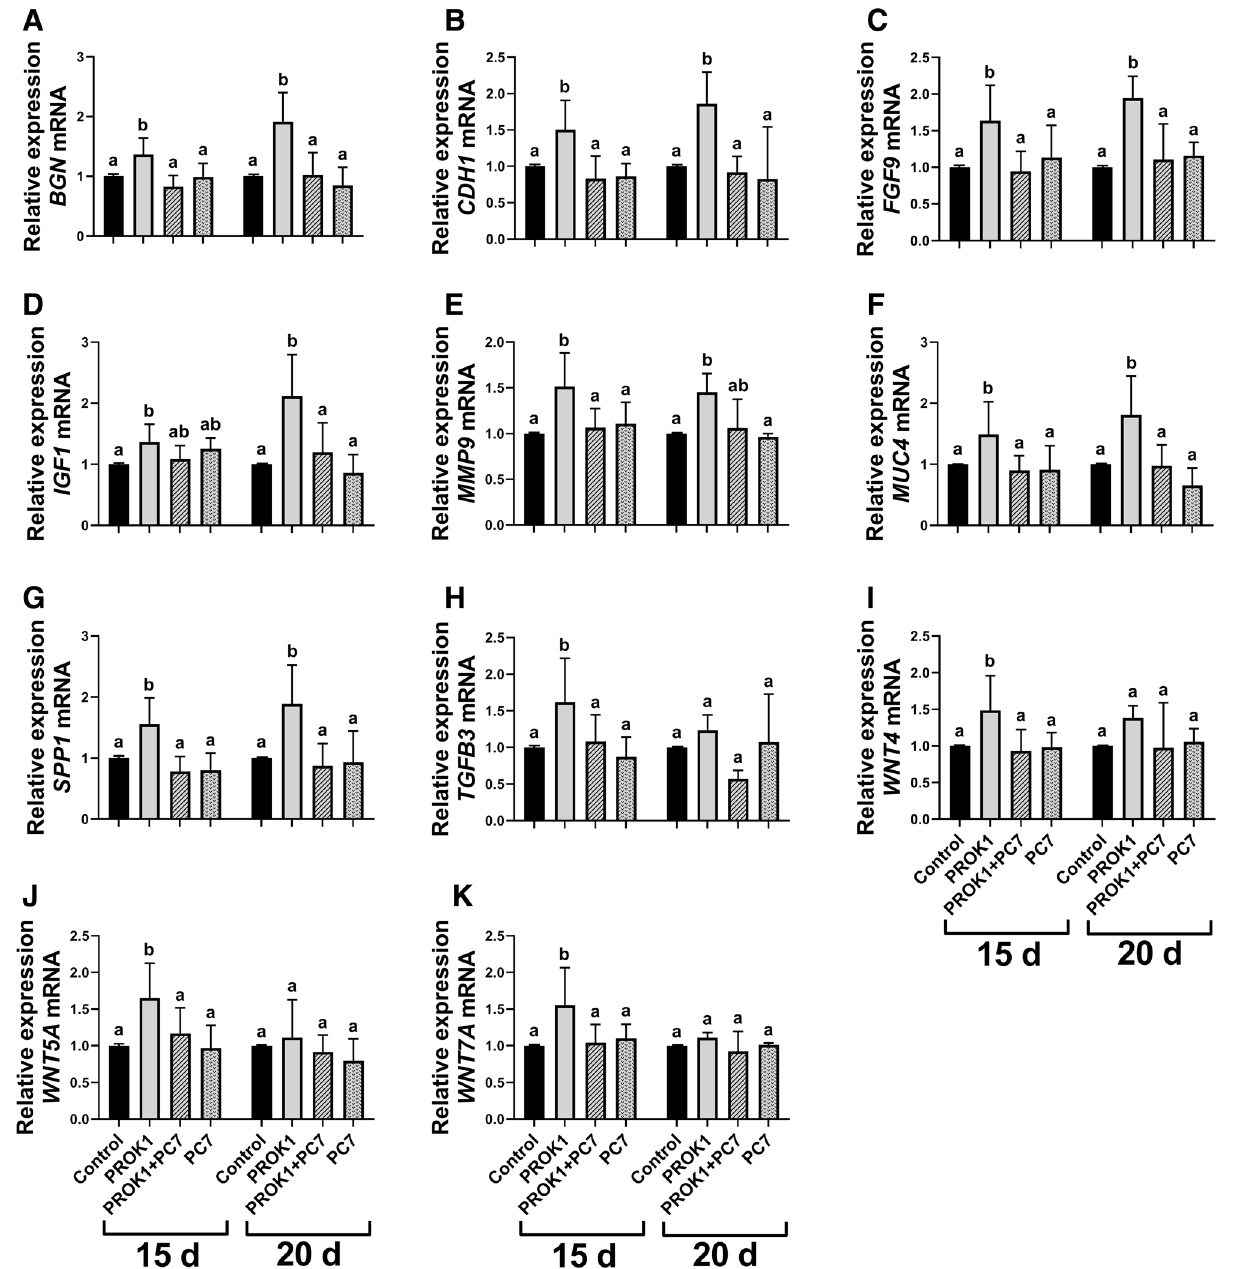
Figure 5. Expression of the genes involved in the regulation of proliferation, adhesion and invasion in the porcine trophoblast is stimulated by the prokineticin 1 (PROK1). The effect of PROK1 on the expression of genes involved mainly in the regulation of proliferation, adhesion and invasion in the porcine trophoblast cells on days 15 and 20 of pregnancy in vitro: ( A ) biglycan ( BGN ); ( B ) cadherin 1 ( CDH1 ); ( C ) fibroblast growth factor 9 ( FGF9 ); ( D ) insulin-like growth factor 1 ( IGF1 ); ( E ) matrix metallopeptidase 9 ( MMP9 ); ( F ) mucin 4 ( MUC4 ); ( G ) secreted phosphoprotein 1 ( SPP1 ); ( H ) transforming growth factor beta 3 ( TGFB3 ); ( I ) Wnt family member 4 ( WNT4 ); ( J ) Wnt family member 5A ( WNT5A ), and ( K ) Wnt family member 7A ( WNT7A ). Primary trophoblast cells were incubated with the control (vehicle) or PROK1 (40 nM) for 24 h in the presence/absence of a PROKR1 antagonist (PC7; 1 µM). Data are presented as the mean ± SEM of the fold change versus control. Different letters (a–b) indicate statistically significant differences ( P < 0.05). Means sharing at least one the same letter indicate no significant